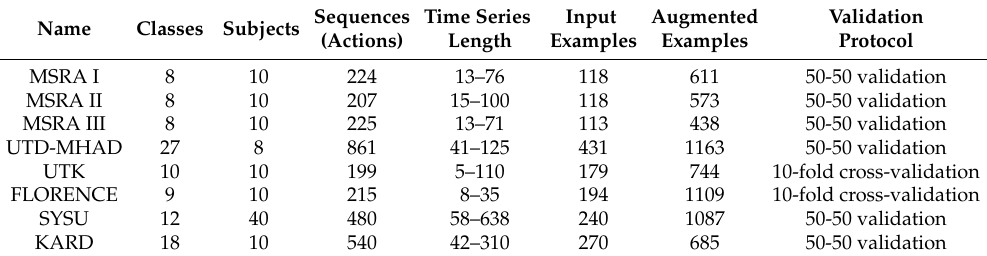
Table 1. Characteristics of datasets used in experiments.